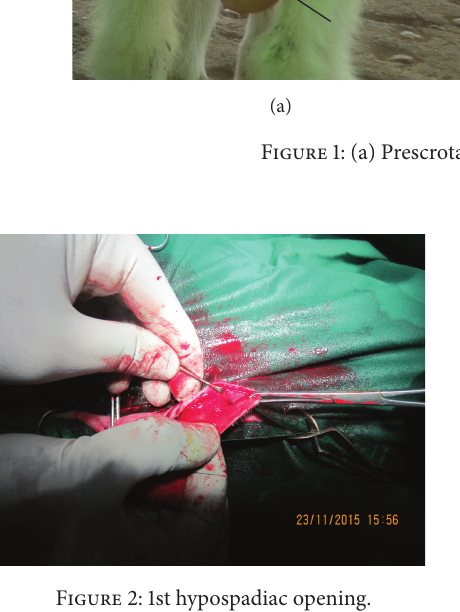
Figure 2: 1st hypospadiac opening. Figure 3: 2nd hypospadiac